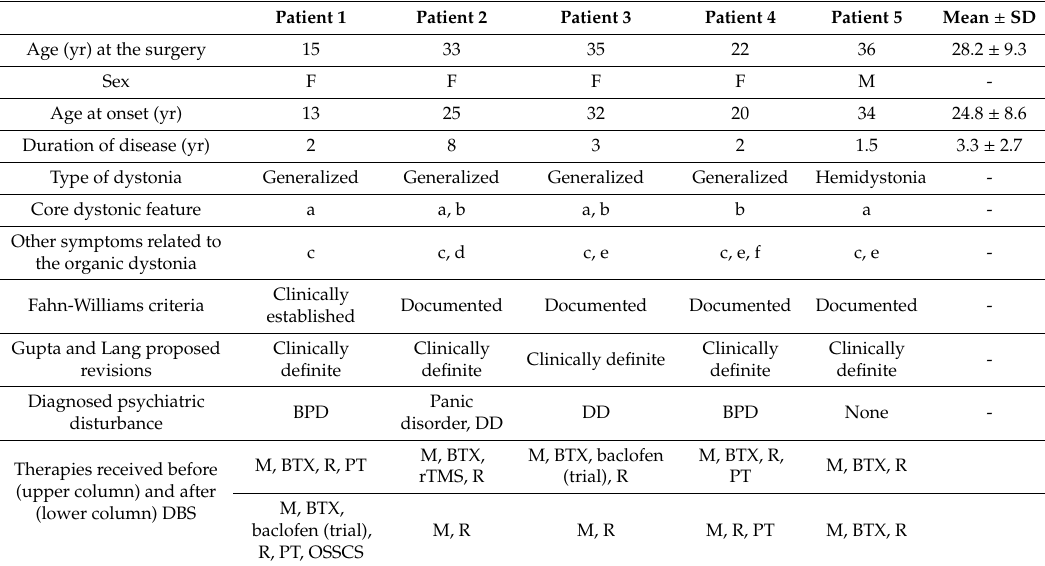
Table 1. Characteristics of patients with borderline dystonia who underwent bilateral pallidal deep brain stimulation. Patient 1 Patient 2 Patient 3 Patient 4 Patient 5 Mean ± SD Age (yr) at the surgery 15 33 35 22 36 28.2 ± 9.3 Sex F F F F M - 13 25 32 20 34 24.8 ± 8.6 2 8 3 2 1.5 3.3 ± 2.7 Type of dystonia Generalized Generalized Generalized Generalized Hemidystonia - Core dystonic feature a a, b a, b b a - c c, d c, e c, e, f c, e - - Clinically - definite Panic DD BPD None disorder, DD